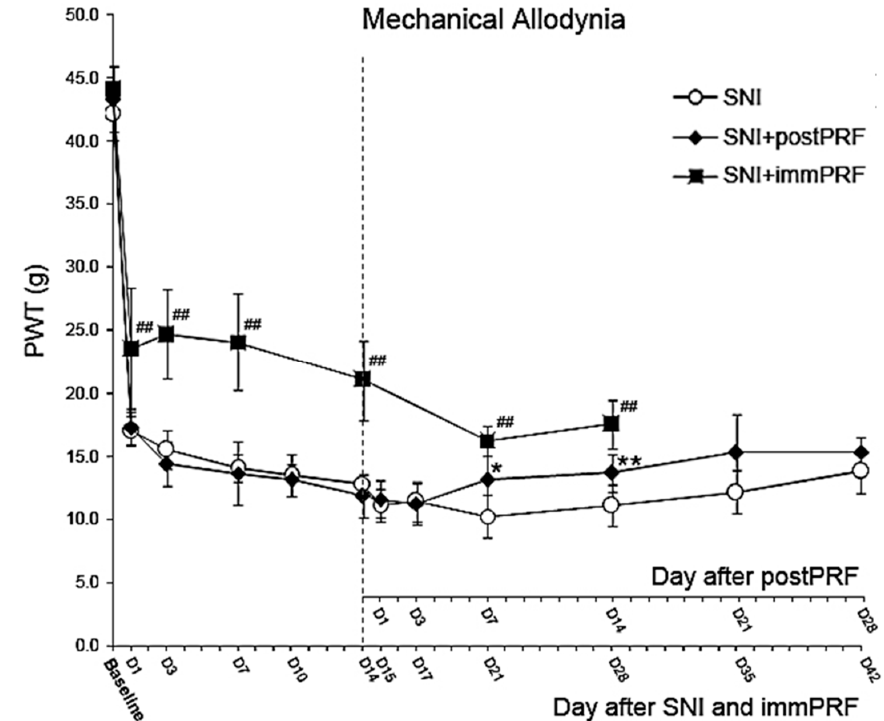
Figure 1. Comparison of PRF treatments applied at two different times: immediately after SNI (SNI + immPRF), and on the 14th day after SNI (SNI + postPRF), in reducing mechanical allodynia in spared nerve injured (SNI) rats. SNI + immPRF group, with immediate PRF-60V (6 min) following